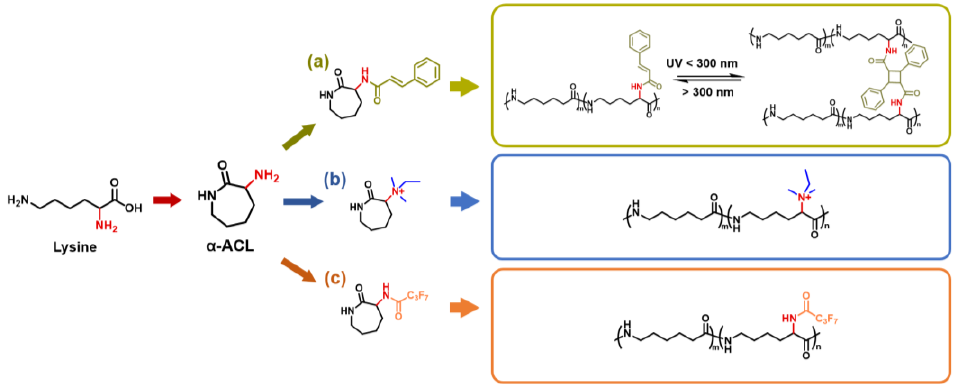
Figure 7. Production strategies of the functional nylon materials in ref. [54,150,151].